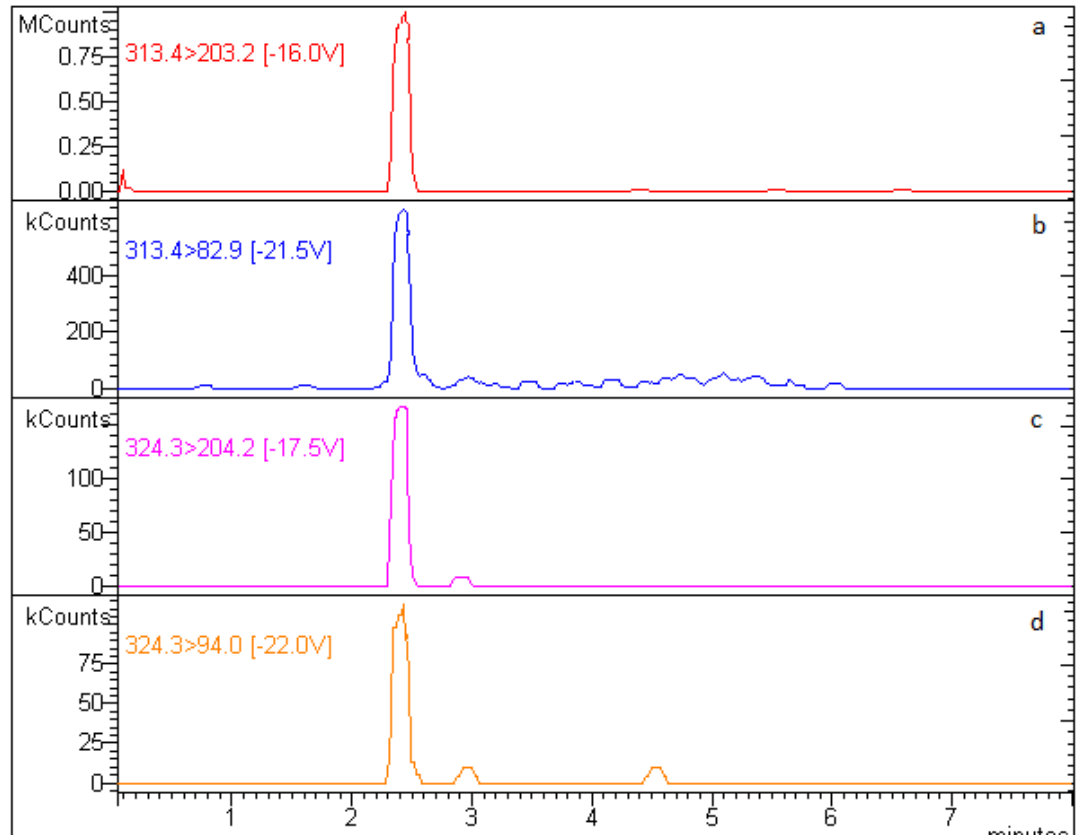
Figure 2. Chromatogram of a drug-free fish muscle sample spiked with PZQ (100 ng/g) and IS (50 ng/g). ( a ) main PZQ transition; ( b ) second PZQ transition; ( c ) main IS transition; ( d ) second IS transition.